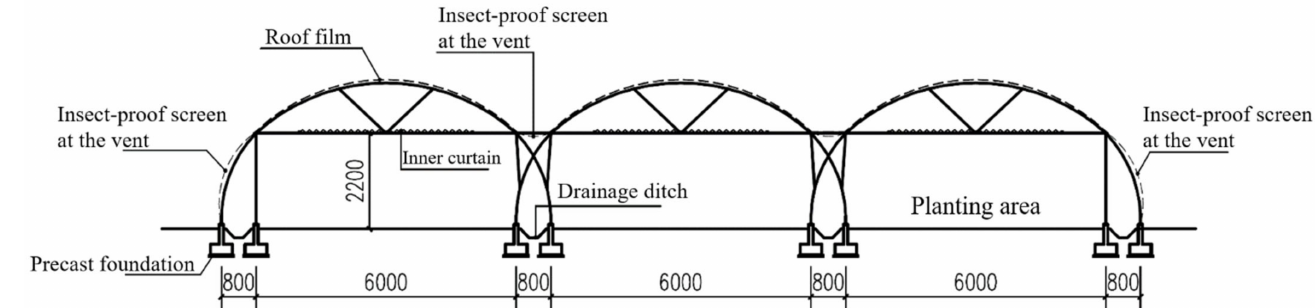
Figure 5. Diagrammatic cross-section of the multi-arch greenhouse structure (unit: